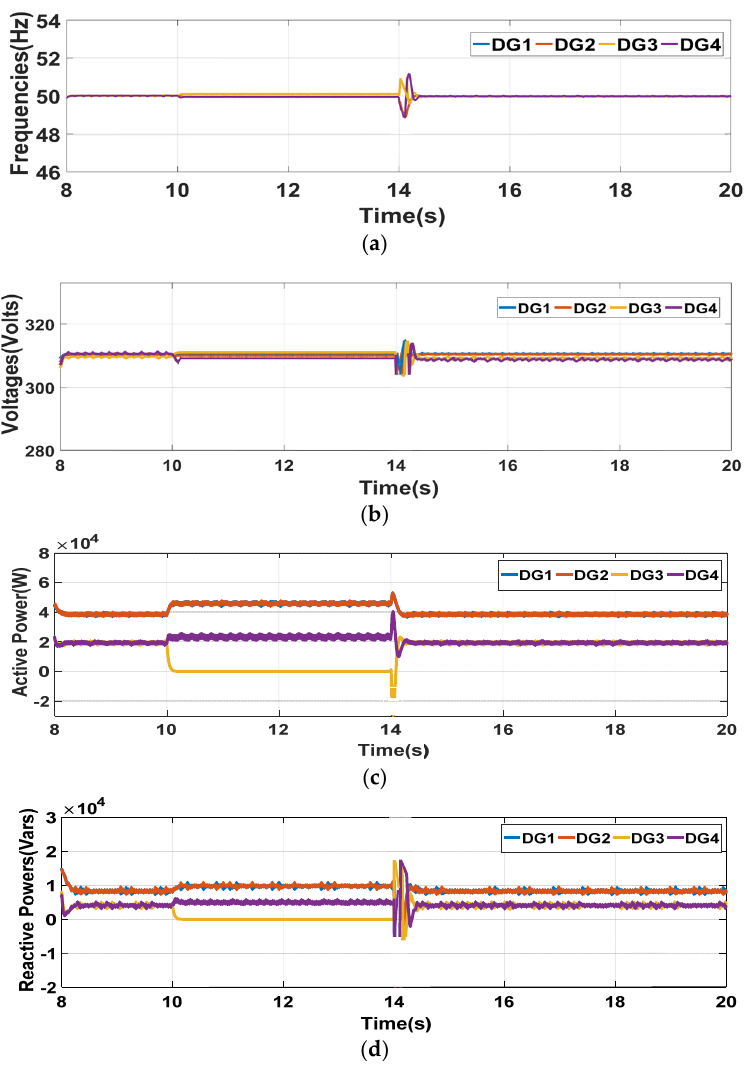
Figure 16. Output results of 4 DGs: ( a ) frequencies ( b ) voltages and ( c ) active power and ( d ) reactive power for case 6.